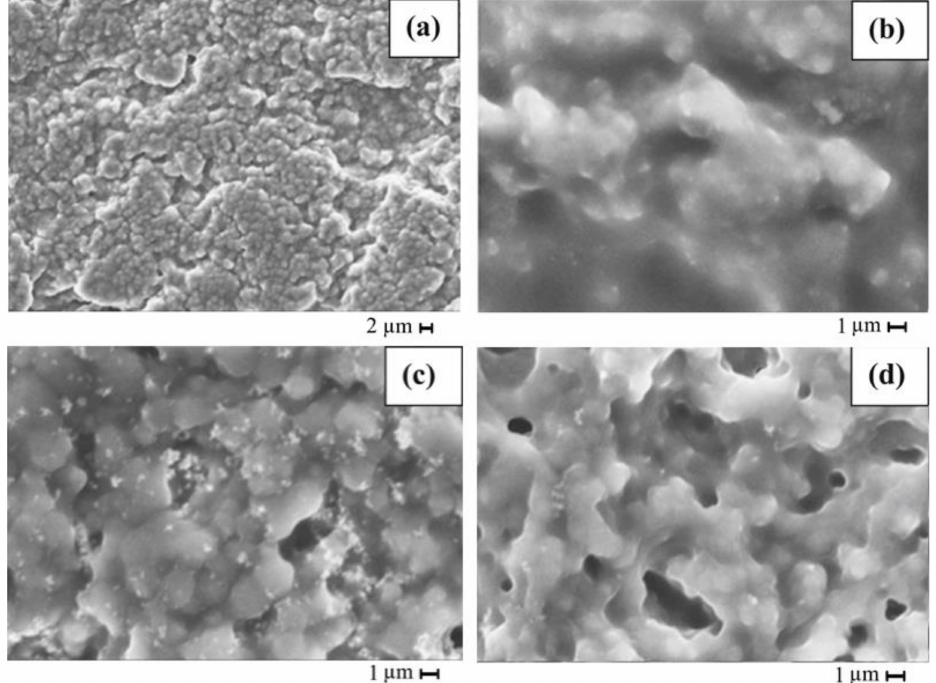
Figure 6. SEM micrographs of EC–PC–Zn(Tf) 2 +PVdF-co-HFP ( a ) gel polymer electrolyte (magnifica- tion, × 1000); ( b ) gel electrolyte with magnification × 5000; and ( c ) its nanocomposites dispersed with ZnO particles of 10 wt % (magnification, × 5000); and ( d ) 25 wt % (magnification, × 5000) Reproduced with permission from J. Solid State Electrochem., 16, Sellam, Enhanced zinc ion transport in gel polymer electrolyte: Effect of nano-sized ZnO dispersion, 3105–3114, 2012